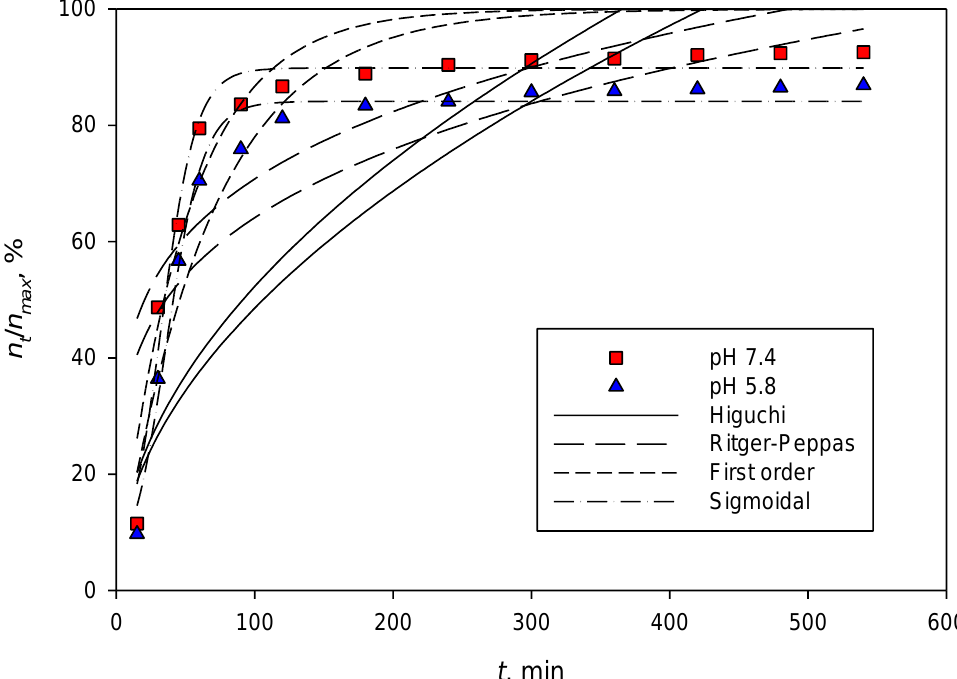
Figure 6. Dexamethasone released from CNCs-rarasaponin at 37 °C.